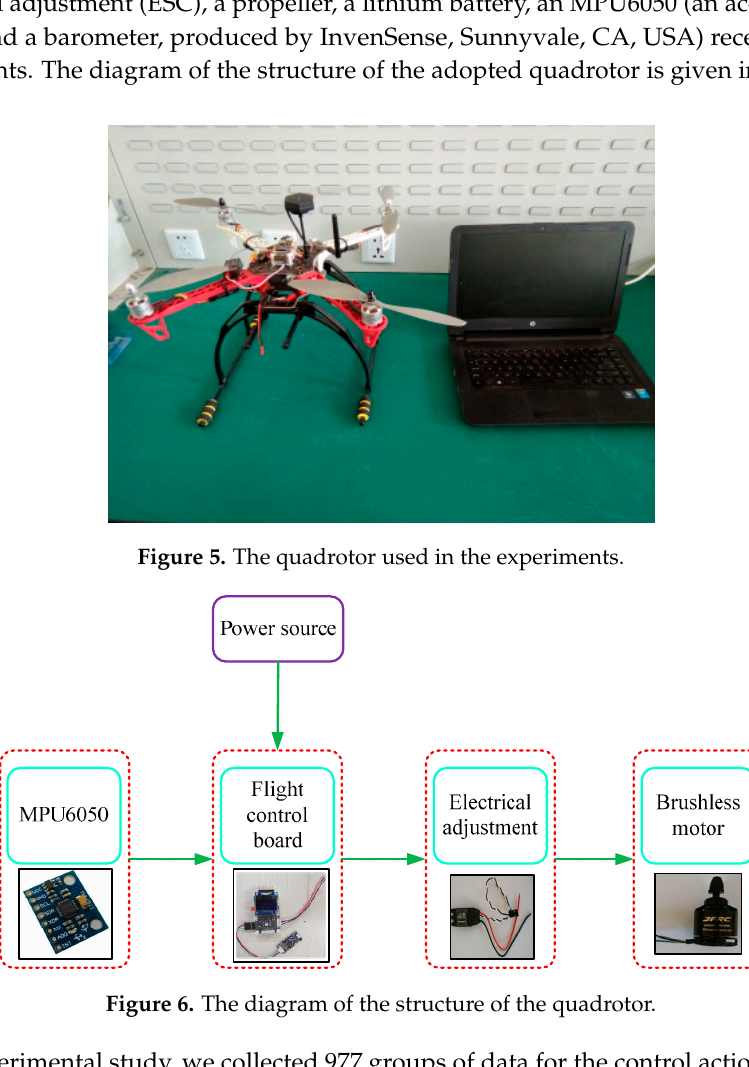
Figure 7. The estimation result of the quadrotor.